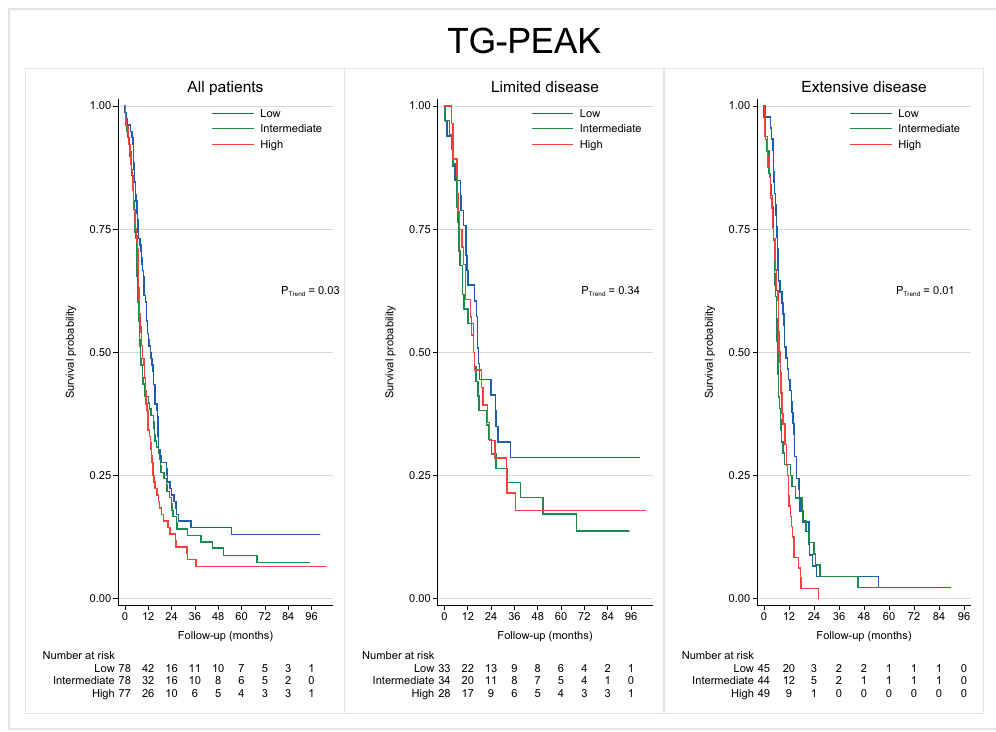
Fig 3. Kaplan-Meier curve of overall survival based on TG-Peak at baseline (tertiles), for all patients and by disease extent.